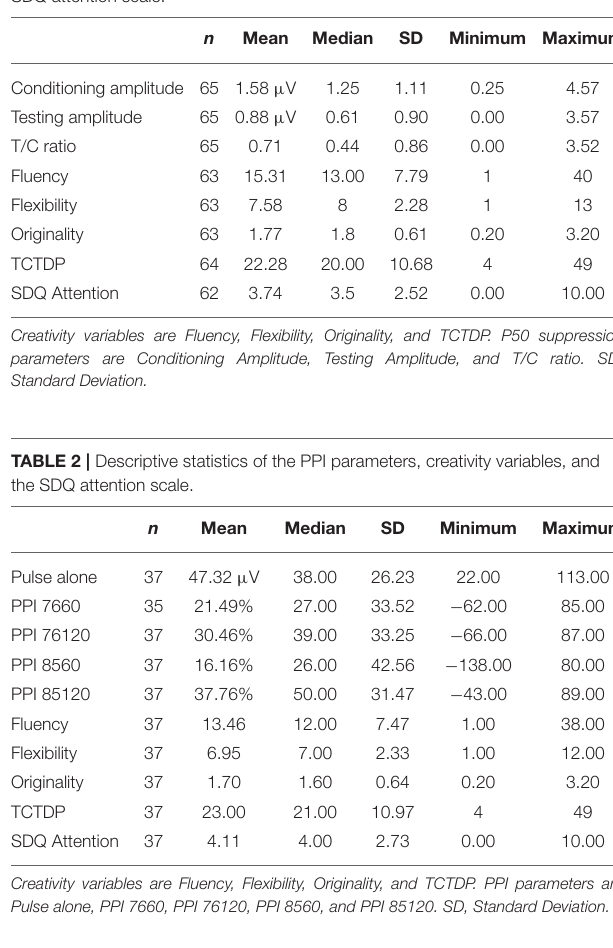
TABLE 3 | ANCOVA statistics for P50 suppression parameters and creativity